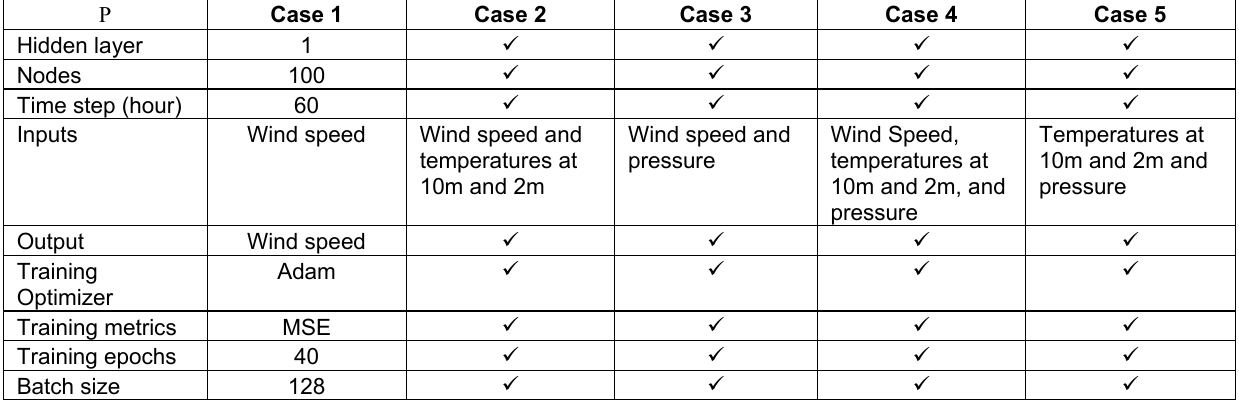
Figure 15. Wind speed prediction in Case 3, (a) 1 hour ahead (b) 2 hours ahead, (c) 5 hours ahead, (d) 7 hours ahead. Table 6. Training parameters for all